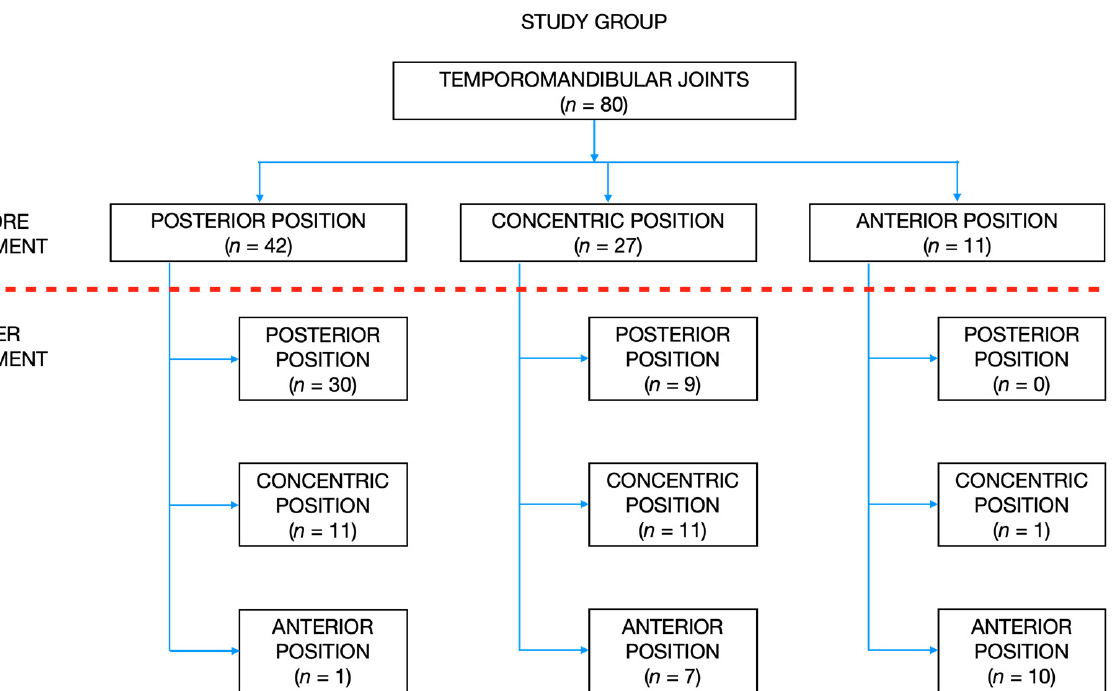
Table 7. The average values of different joint spaces and condylar ratio before and after the end of the treatment in the study group.